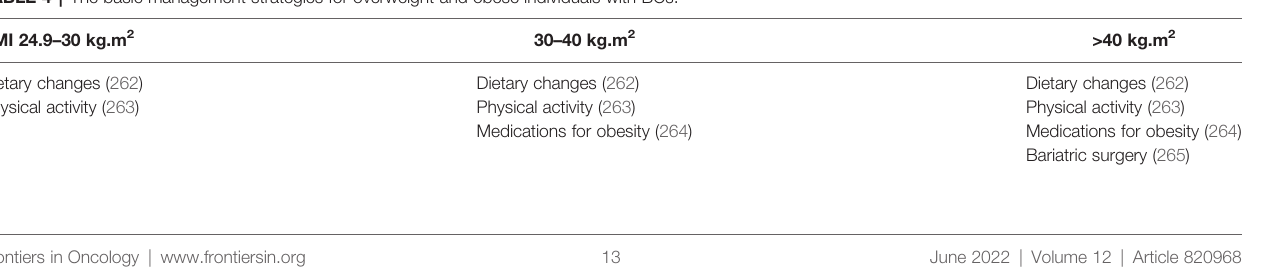
TABLE 4 | The basic management strategies for overweight and obese individuals with